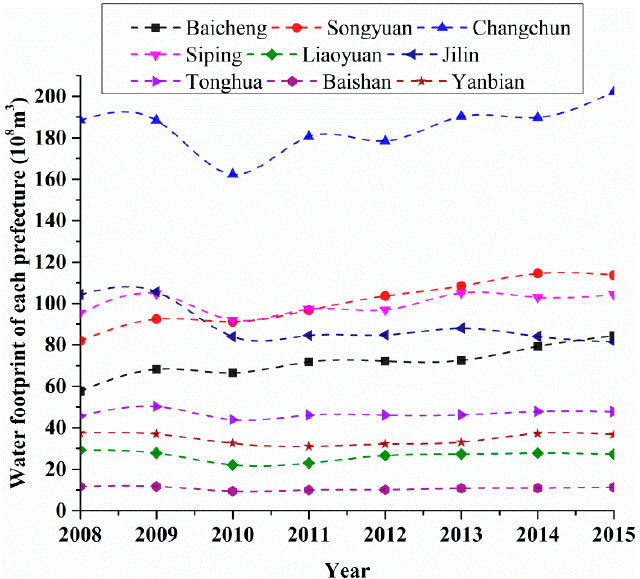
Figure 4. WFs of nine prefectures in Jilin Province from 2008 to 2015.